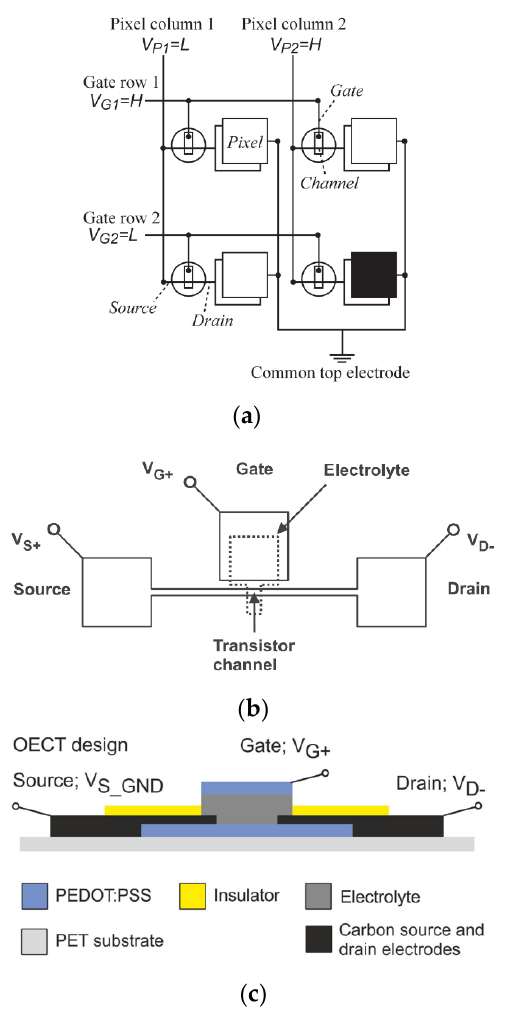
Figure 8. ( a ) Schematic drawing of the circuit layout of the active-matrix EC display [73]. ( b ) Top view of a laterally configured PEDOT:PSS-based depletion mode electrochemical transistor [62]. ( c ) Schematic architecture of a vertically configured organic electrochemical transistor device [64].